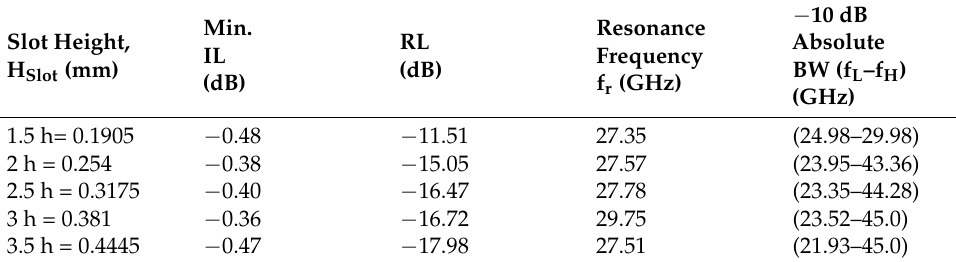
Table 3. Effect of slot height variations with d = 1.9 mm.